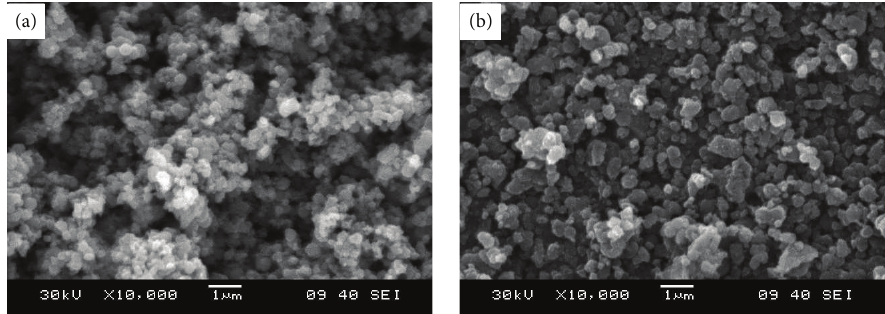
Figure 4: SEM photos of (a) Li,Pr:Y 2 SiO 5 and (b) TiO 2 /Li,Pr:Y 2 SiO 5 nanomaterials.